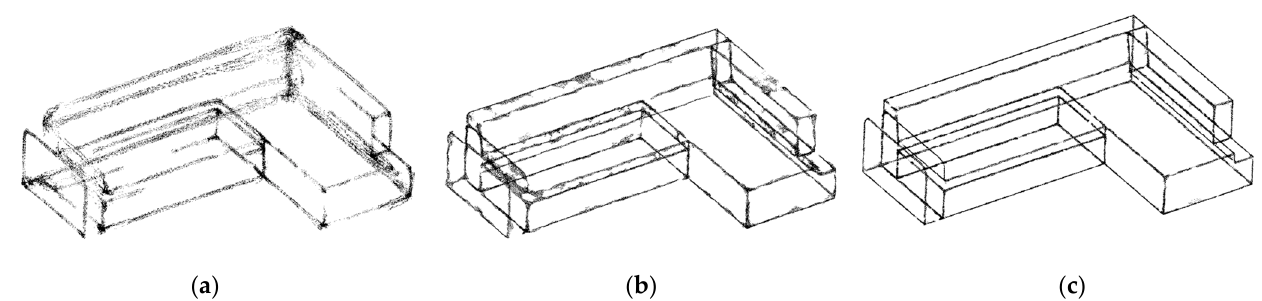
Figure 10. Results of the upsampling when using ( a ) PU-NET, ( b ) PU-GAN, and ( c ) our proposed deep learning network.